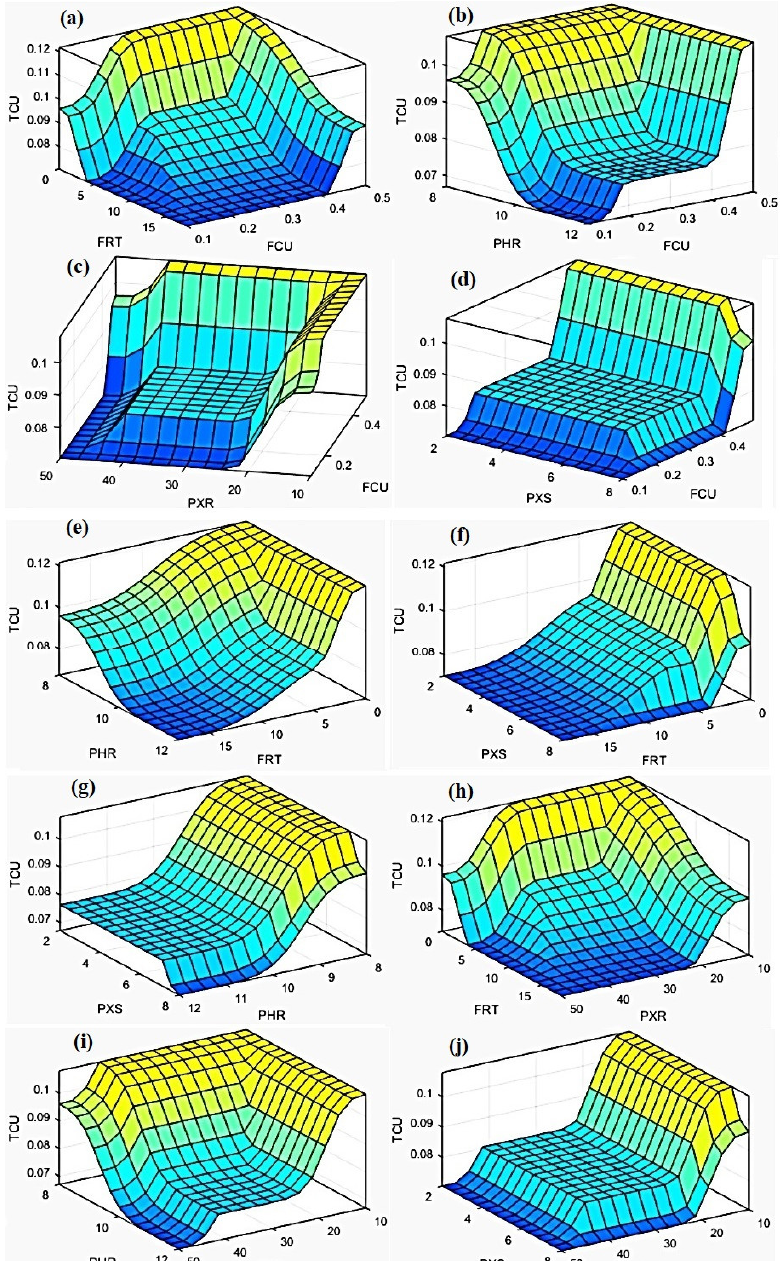
Figure 9. Resulting response surfaces of the PMM model—dependence of copper content in final tailings (TCU) on input parameters. ( a ) copper content in the feed (FCU) and frother consumption (FRT); ( b ) copper content in the feed (FCU) and pH value of slurry at rougher flotation circuit (PHR); ( c ) copper content in the feed (FCU) and collector consumption at rougher flotation circuit (PXR);